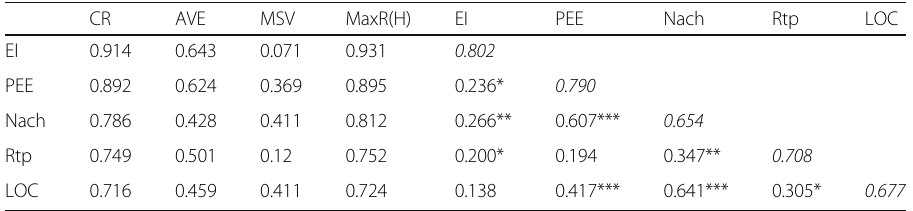
Table 3 Model discriminant validity